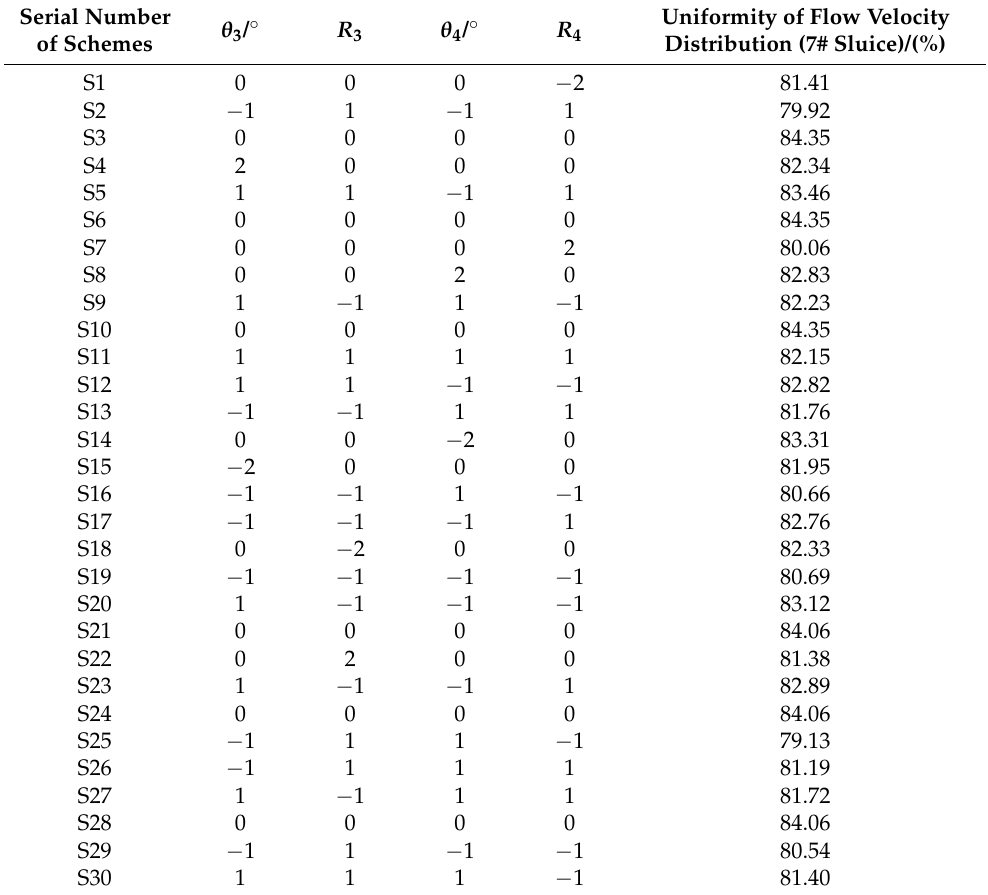
Table 4. Results of indicators of the schemes in the CCD-Response Surface Method under the operational state of